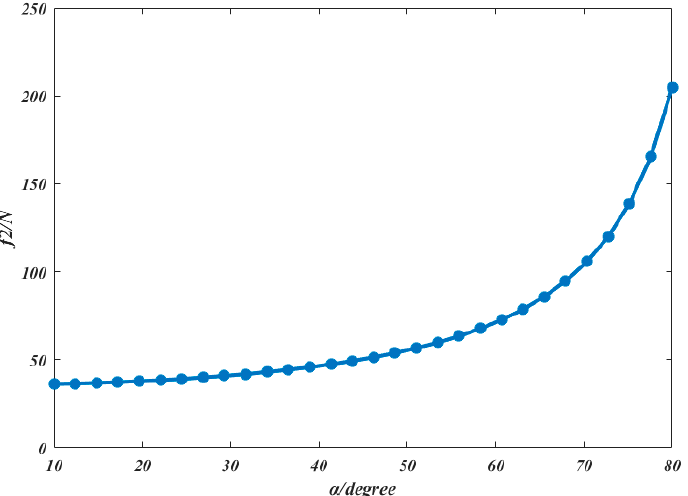
Figure 12. Grasping force under the parallel grasping mode.